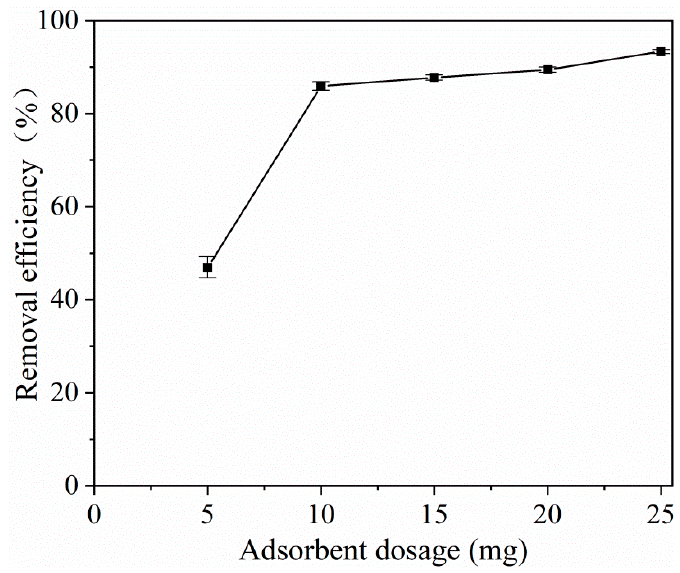
Figure 5. Adsorbent dosage effect on the adsorption of tetracycline. ( C 0 = 20 mg L − 1 , V = 10 mL, T = 25 °C, t = 120 min).